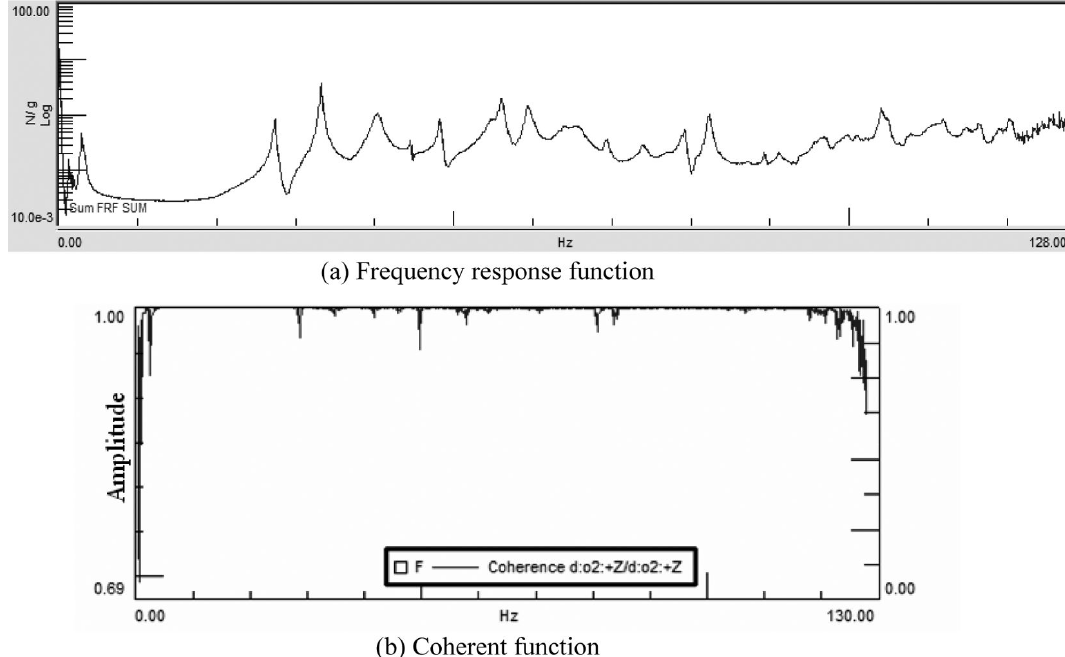
Fig. 10. Frequency response function and coherent function obtained in modal testing.